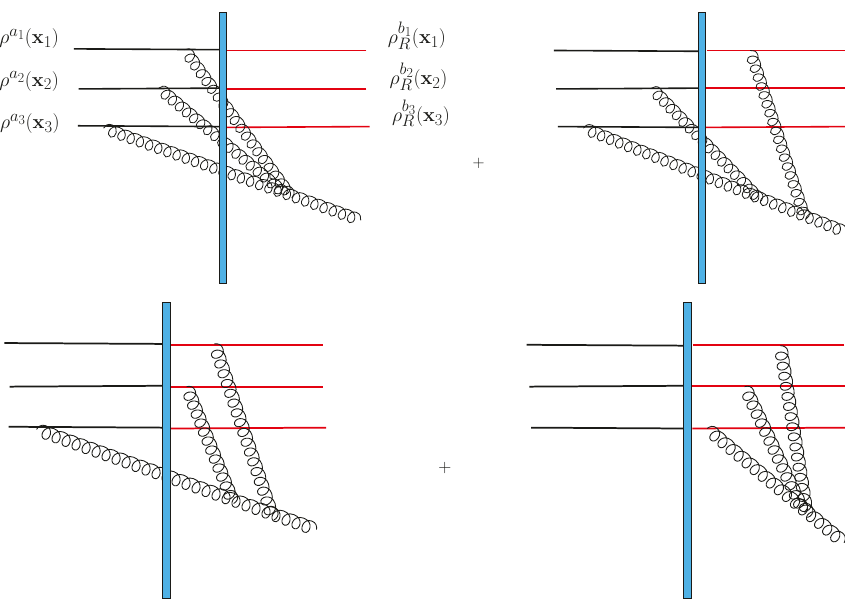
Figure 8 . Schematic representation of the color structure for the double commutators in β (5) ( τ, k ) . The shaded bar represents the target nucleus. The eikonally rotated color charge density ρ represented using red lines.